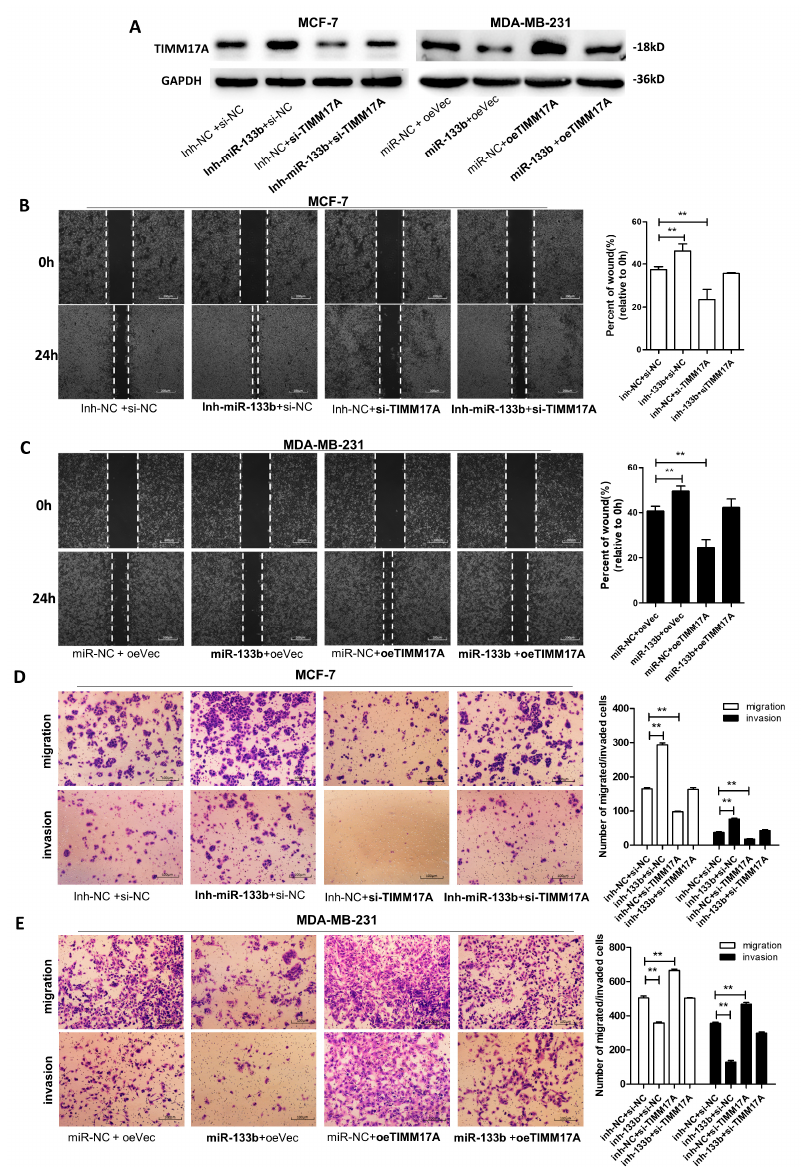
Figure 5. miR-133b promotes breast cancer cells migration and invasion via targeting TIMM17A ( A ) TIMM17A protein levels in MCF-7 cells transfected with inh-NC plus control siRNA(si-NC), inh- miR-133b plus si-NC, inh-NC plus TIMM17A siRNA (si-TIMM17A), or inh- miR-133b plus si-TIMM17A, and in MDA-MB-231 cells transfected with miR-NC plus control vector(oeVec), miR-133b plus oeVec, miR-NC plus TIMM17A vector (oeTIMM17A), or miR-133b plus oeTIMM17A. ( B , C ) Migration of MCF-7 cells transfected with inh-NC plus control siRNA(si-NC), inh- miR-133b plus si-NC, inh-NC plus TIMM17A siRNA (si-TIMM17A), or inh- miR-133b plus si-TIMM17A ( B ), and MDA-MB-231 cells transfected with miR-NC plus control vector(oeVec), miR-133b plus oeVec, miR-NC plus TIMM17A vector (oeTIMM17A), or miR-133b plus oeTIMM17A ( C ) detected by wound healing assay. Scale bar, 100 µ m. ( D , E ) Migration and invasion of MCF-7 cells transfected with inh-NC plus control siRNA(si-NC), inh- miR-133b plus si-NC, inh-NC plus TIMM17A siRNA (si-TIMM17A), or inh- miR-133b plus si-TIMM17A ( D ), and MDA-MB-231 cells transfected with miR-NC plus control vector(oeVec), miR-133b plus oeVec, miR-NC plus TIMM17A vector (oeTIMM17A), or miR-133b plus oeTIMM17A ( E ) detected by transwell migration and invasion assay. Scale bar, 100 µ m. ** p < 0.01; *** p <